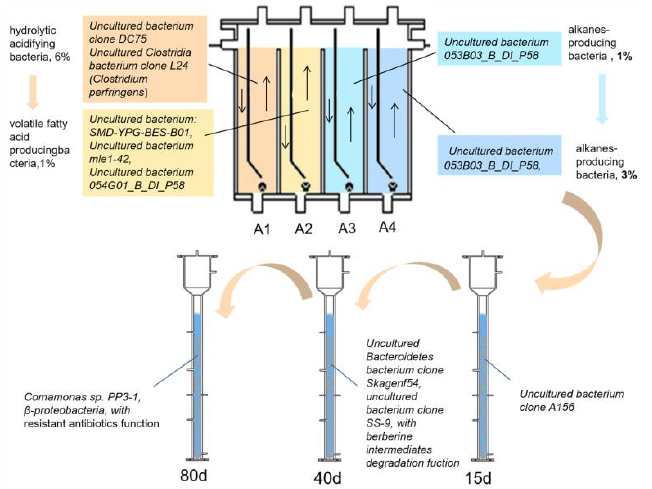
Figure 5. The schematic diagram of dynamic shift of bacterial communities in the hybrid ABR– AGS system.